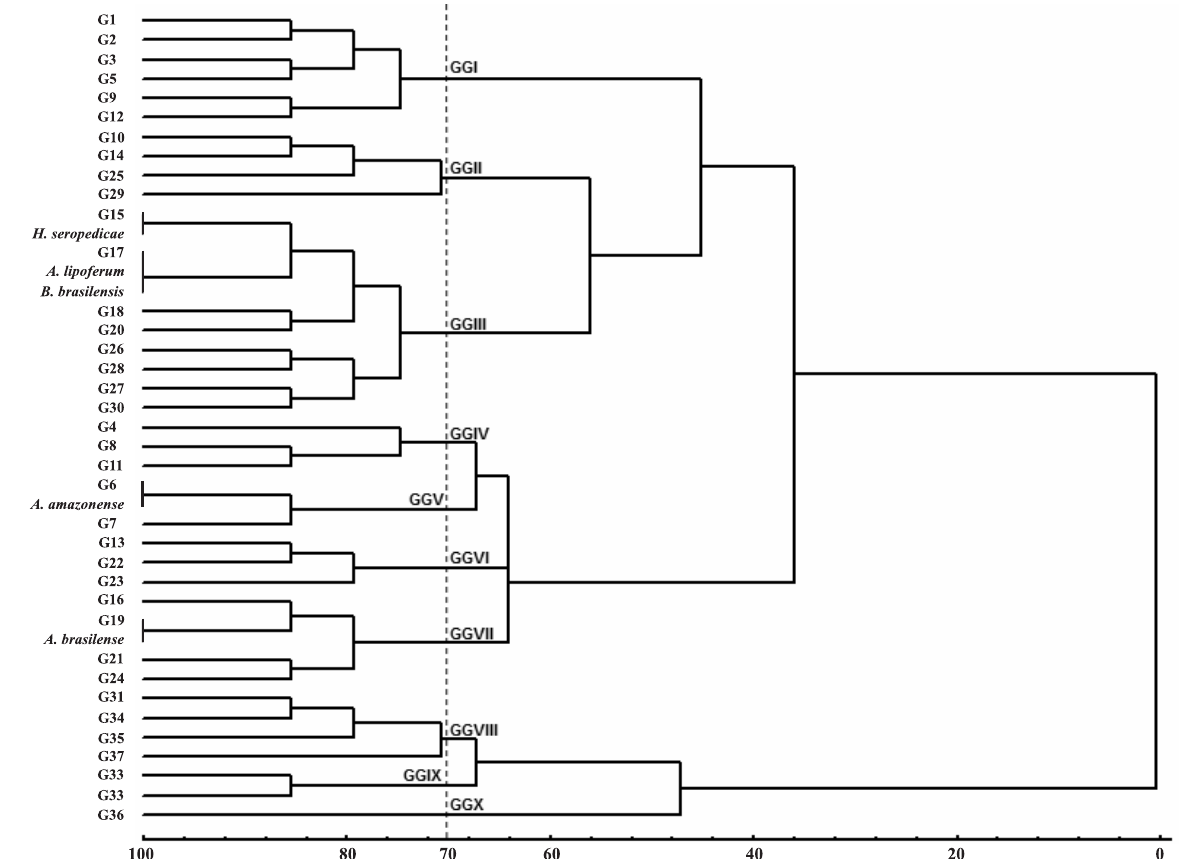
Figura 3. Dendrograma de similaridade considerando as características fenotípicas culturais (cor, tamanho e consistência de colônias) de isolados e estirpes-tipo de bactérias diazotróficas não simbióticas, para a coleta de